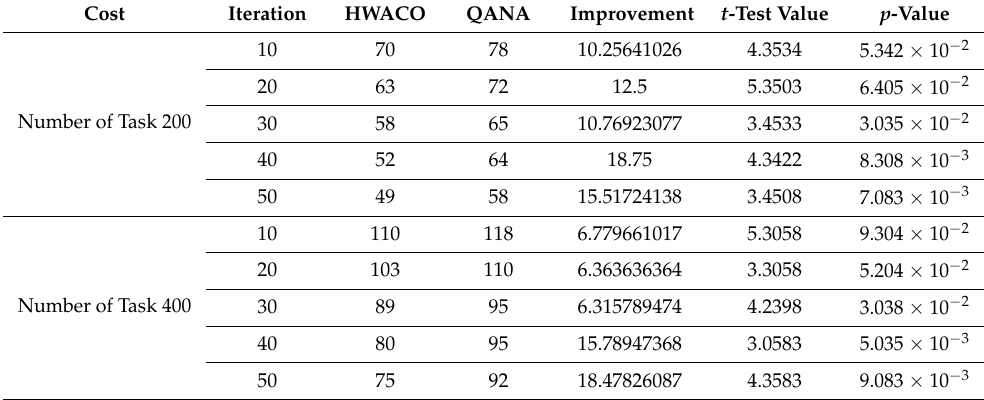
Table 9. t -Test for cost between HWACO and QANA.